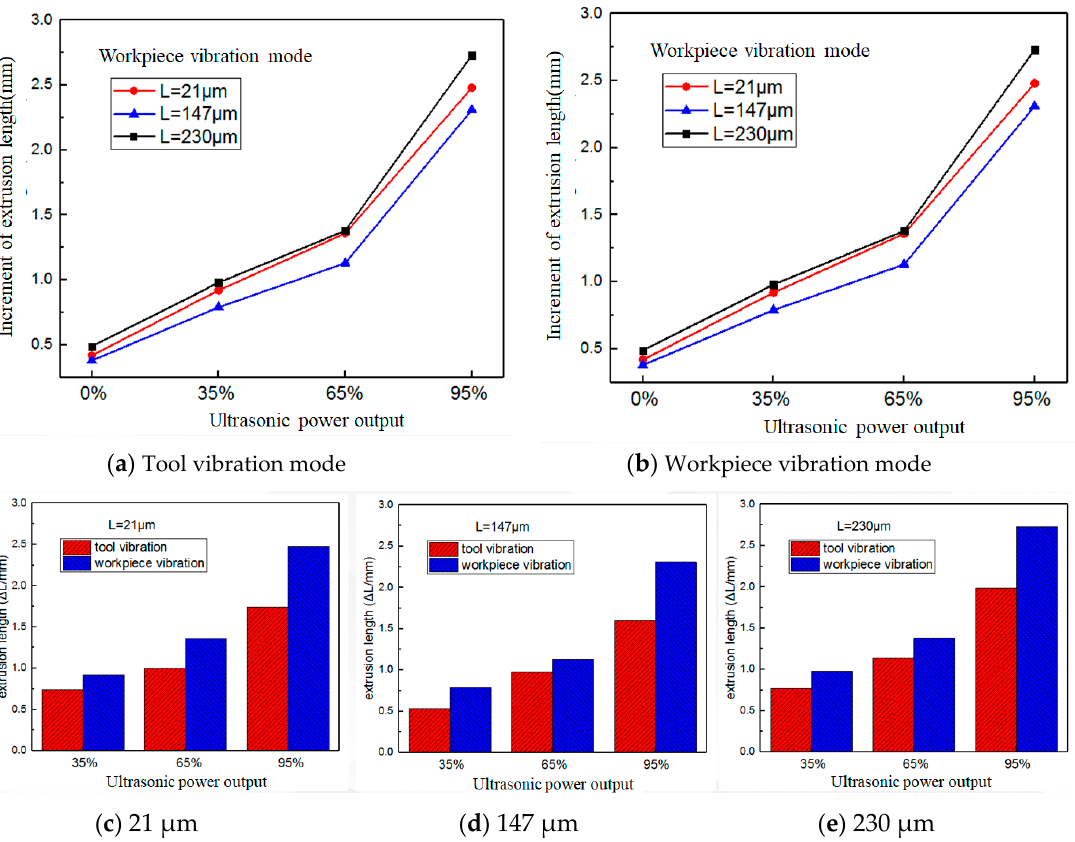
Figure 8. Increment of micro-extrusion length with different ultrasonic power outputs and vibration